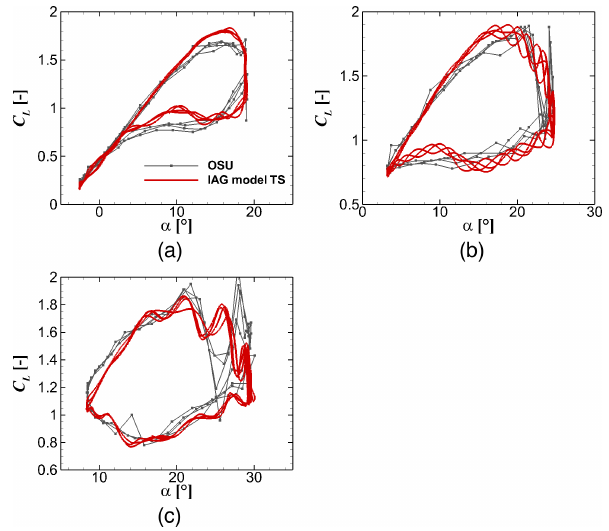
Figure 12. Lift reconstruction by the IAG model in comparison with the measurement data (Ramsay et al., 1996) for (cid:49)t = T/ 1440 using the actual angle of attack in the experimental campaign at various α values. From (a) to (c) : α = 8, α = 14 and α = 20 ◦ . S801 airfoil, k = 0 . 073 and (cid:49)α = 10 ◦ .